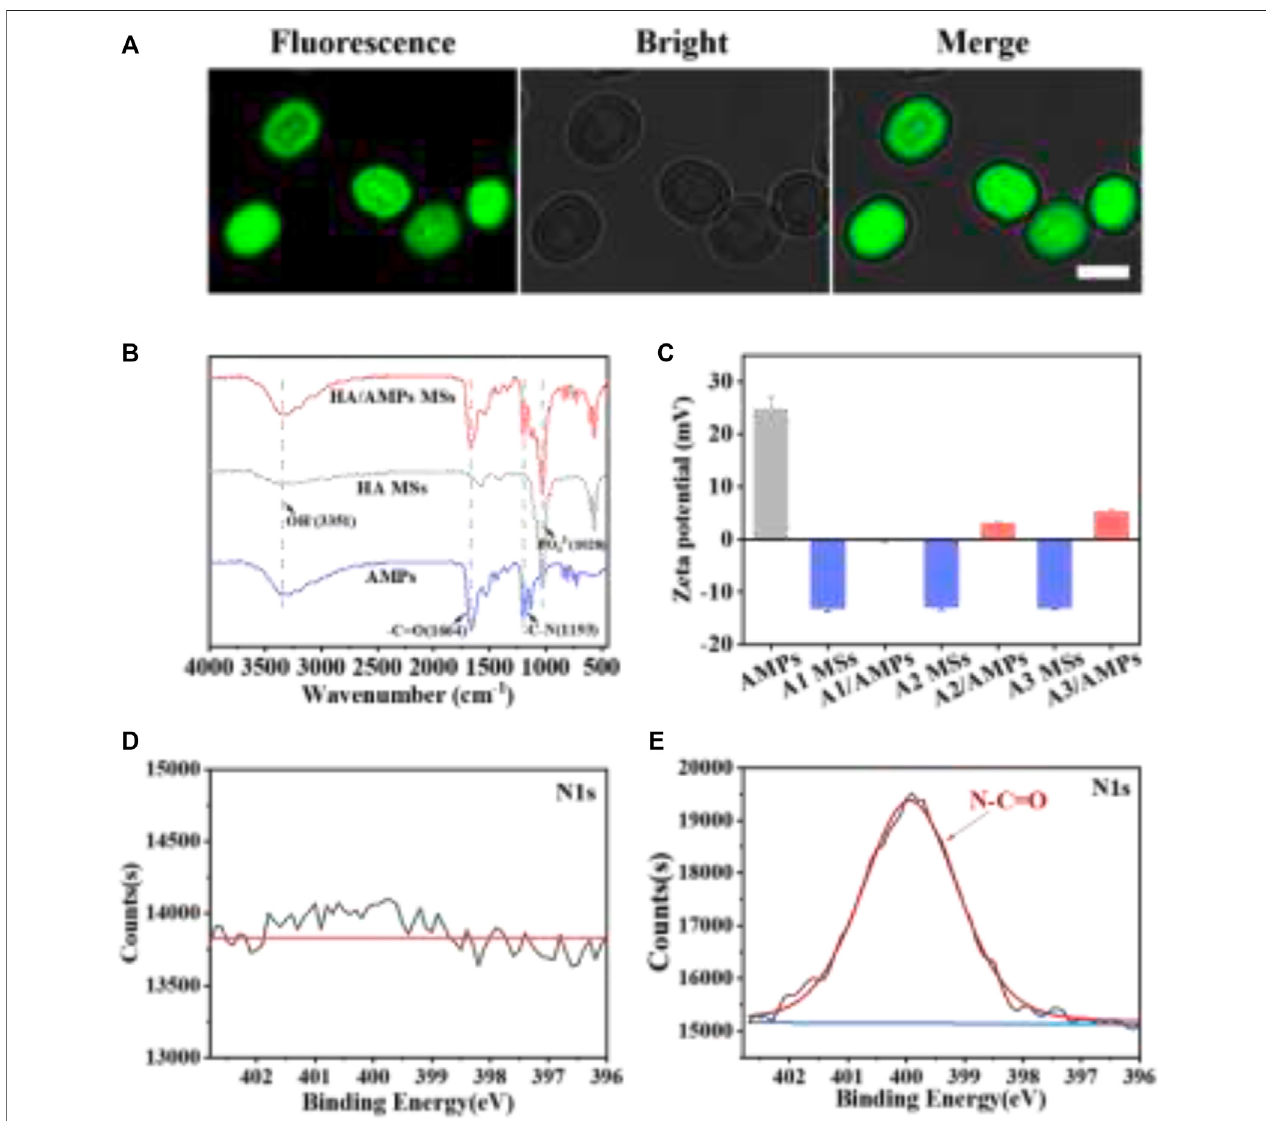
FIGURE2| Thephysicochemicalpropertiesofcompositemicrospheres. (A) VisualizeddistributionofFITC-AMPsonrepresentativeHAMSsbyLSCM,bar (cid:2) 2 µm. (B) FTIR spectra of representative HA MSs and HA/AMPs MSs. (C) Analysis of zeta potential. (D,E) N1s spectra of HA MSs and HA/AMPs MSs by XPS.